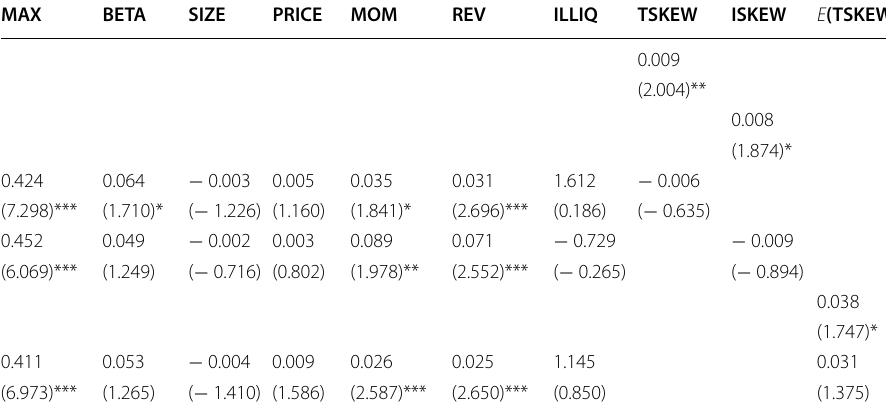
Each week from January 2014 to September 2020, we conduct a cryptocurrency‑level cross‑sectional regression of the return in that week on lagged explanatory variables, which are lagged TSKEW, ISKEW, E (TSKEW), and MAX as well as six other control variables ‑ BETA, SIZE, PRICE, MOM, REV and ILLIQ. TSKEW refers to the total skewness measured for past month using daily returns. ISKEW is the skewness of regression residuals. E (TSKEW) refers to the expected total skewness fitted each week throughout the cross‑sectional regressions. MAX refers to the maximum daily return within a month. BETA is the market beta calculated as the sum of coefficients on lag, current and lead returns on market portfolio. SIZE equals the natural logarithm of the cryptocurrency’s market capitalization by the end of previous week. PRICE is the natural logarithm of one plus the cryptocurrency’s price. MOM stands for momentum that equals the cumulative return over the previous three weeks skipping past week. REV stands for short‑term reversal and equals the return in the past week. ILLIQ refers to Amihud illiquidity measure, which is calculated by the ratio of absolute daily cryptocurrency return to its mean dollar trading volume. Both dependent and independent variables are winsorized at 5% level from upper and lower tails. Table reports the time‑series averages of the cross‑sectional regression coefficients and corresponding t‑statistics. Newey‑West (1987) adjusted t‑statistics are presented in parentheses ***, ** and * denote significance at 1%, 5% and 10%,